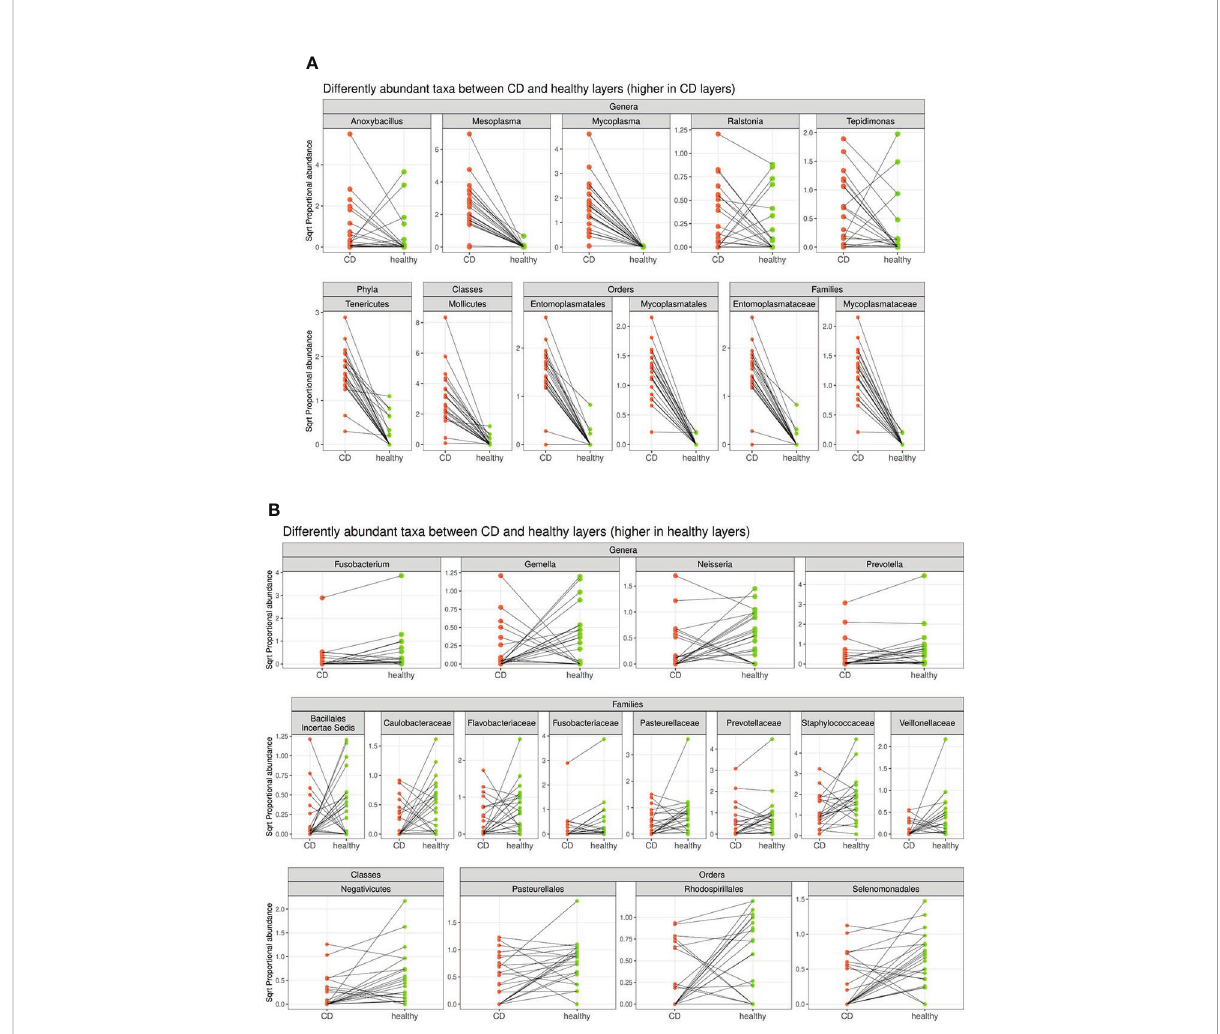
FIGURE 4 Segment plot depicting signi fi cantly different taxa (phylum, classes, families, orders, and genera) between CD (A) and healthy tissues (B) . Lines connect paired samples and highlight the differences in normalized abundance for the indicated rank. Red or blue colors highlight a decrease or increase in CD vs . healthy tissues, respectively. Numbers on the top – left corner represent counts of decreased (red) and increased (blue) measurement for paired samples. Plot titles report the shrunken log2 fold change between in fl amed and non – in fl amed tissues (according to the DESeq2 function lfcShrink). All taxa tested have a p – value